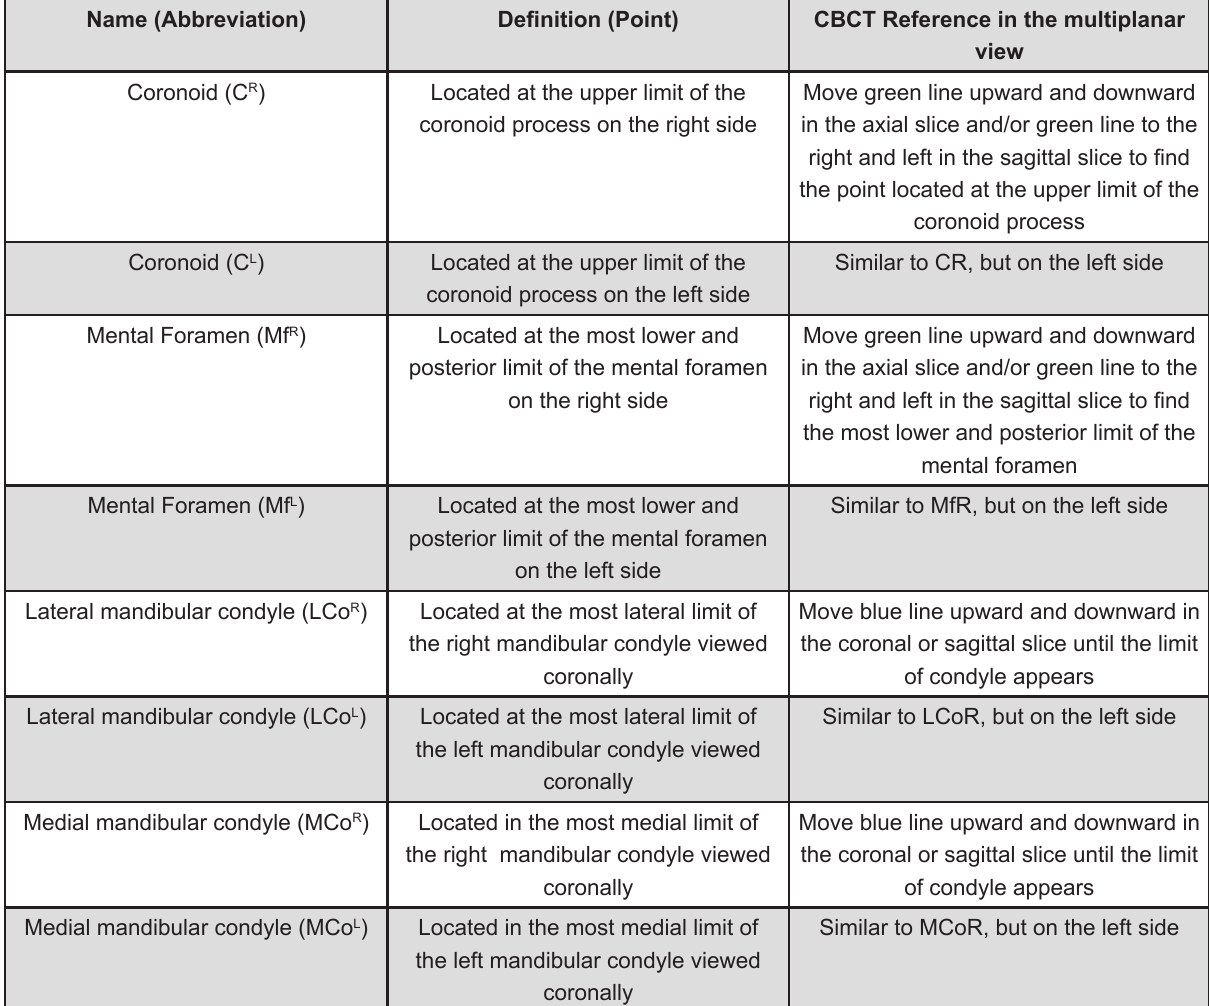
Figure 2- Points. Reference in the anatomical view and in the cone-beam computed tomography (CBCT) images